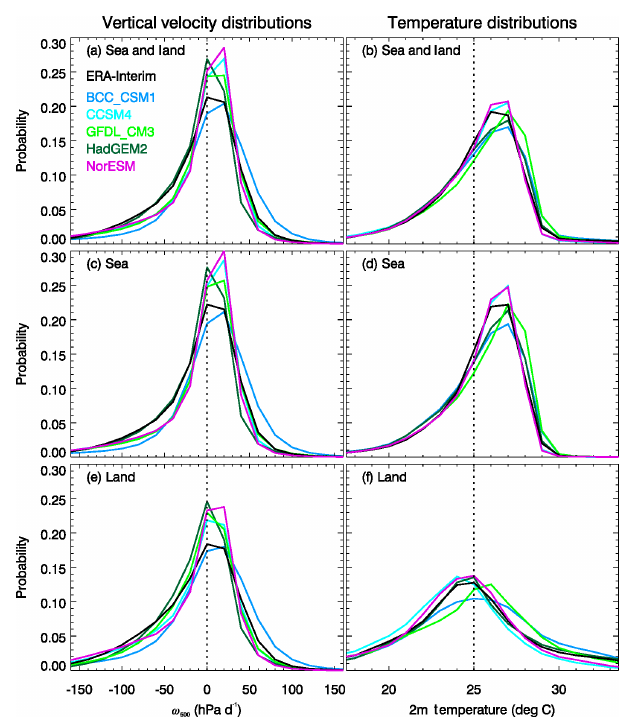
Figure 2. Distribution of vertical velocity ω 500 (left) and near- surface temperature T 2m (right) in the tropics over sea and land (a, b) , over sea only (c, d) , and over land (e, f) , shown for ERA-Interim as proxy for the observations (black) and for five cli- mate models